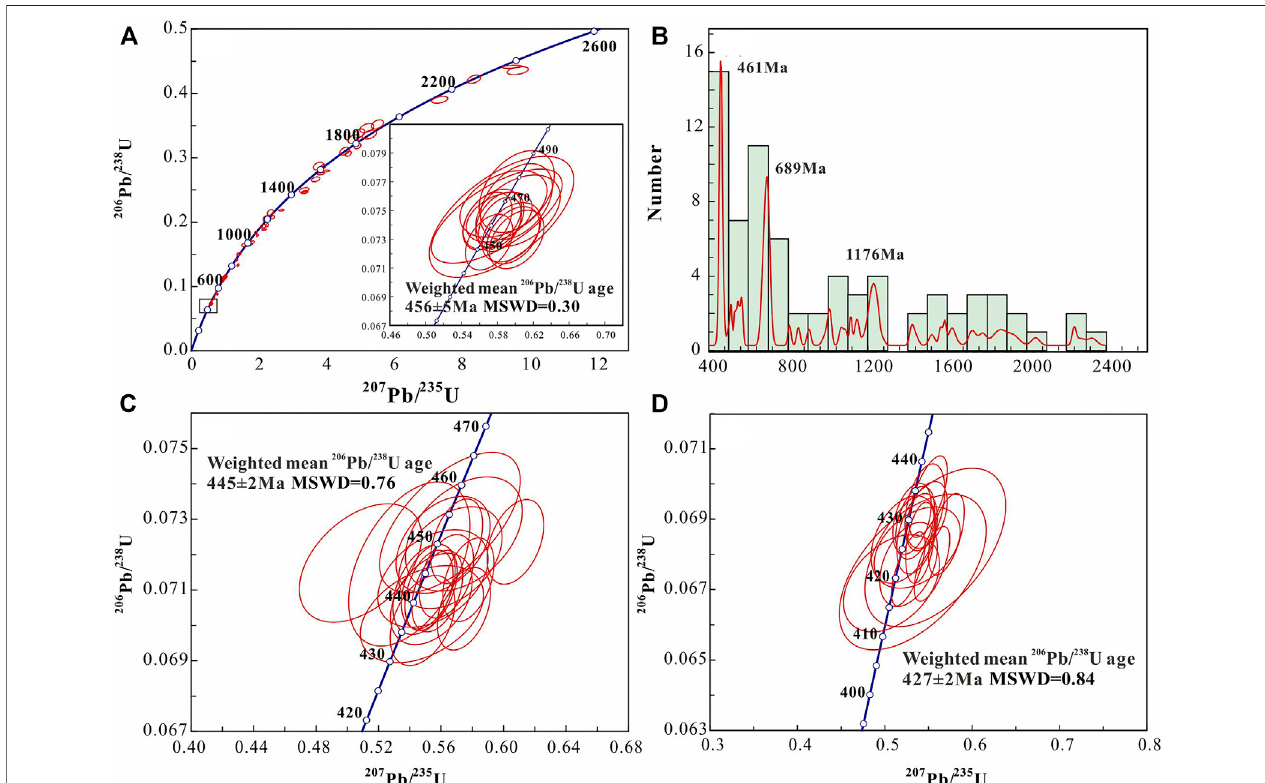
FIGURE 11 | (A) Concordia diagrams showing zircon U-Pb data of sample EL11; (B) Relative probability histogram of U – Pb ages of the detrital zircons in sample EL11; (C) Concordia diagrams showing detrital zircon U-Pb data in sample EL07; (D) Concordia diagrams showing magmatic zircon U-Pb data in sample EL12.